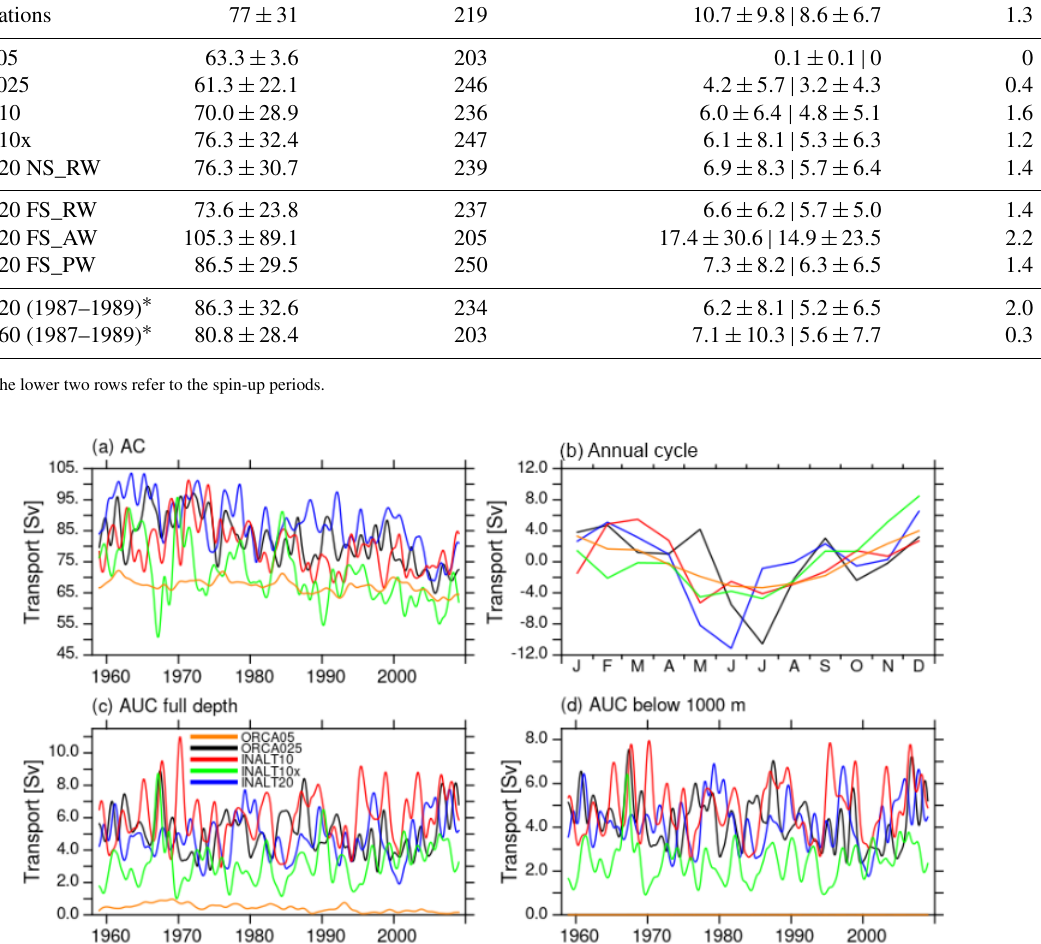
Figure 15. Agulhas Current transport time series (a) and annual cycle of transport anomalies (b) (in Sv). Agulhas Undercurrent transport (in Sv) defined as the full depth-integrated (c) and below 1000m depth (d) northeastward velocity across the ACT section between the coast and 200km